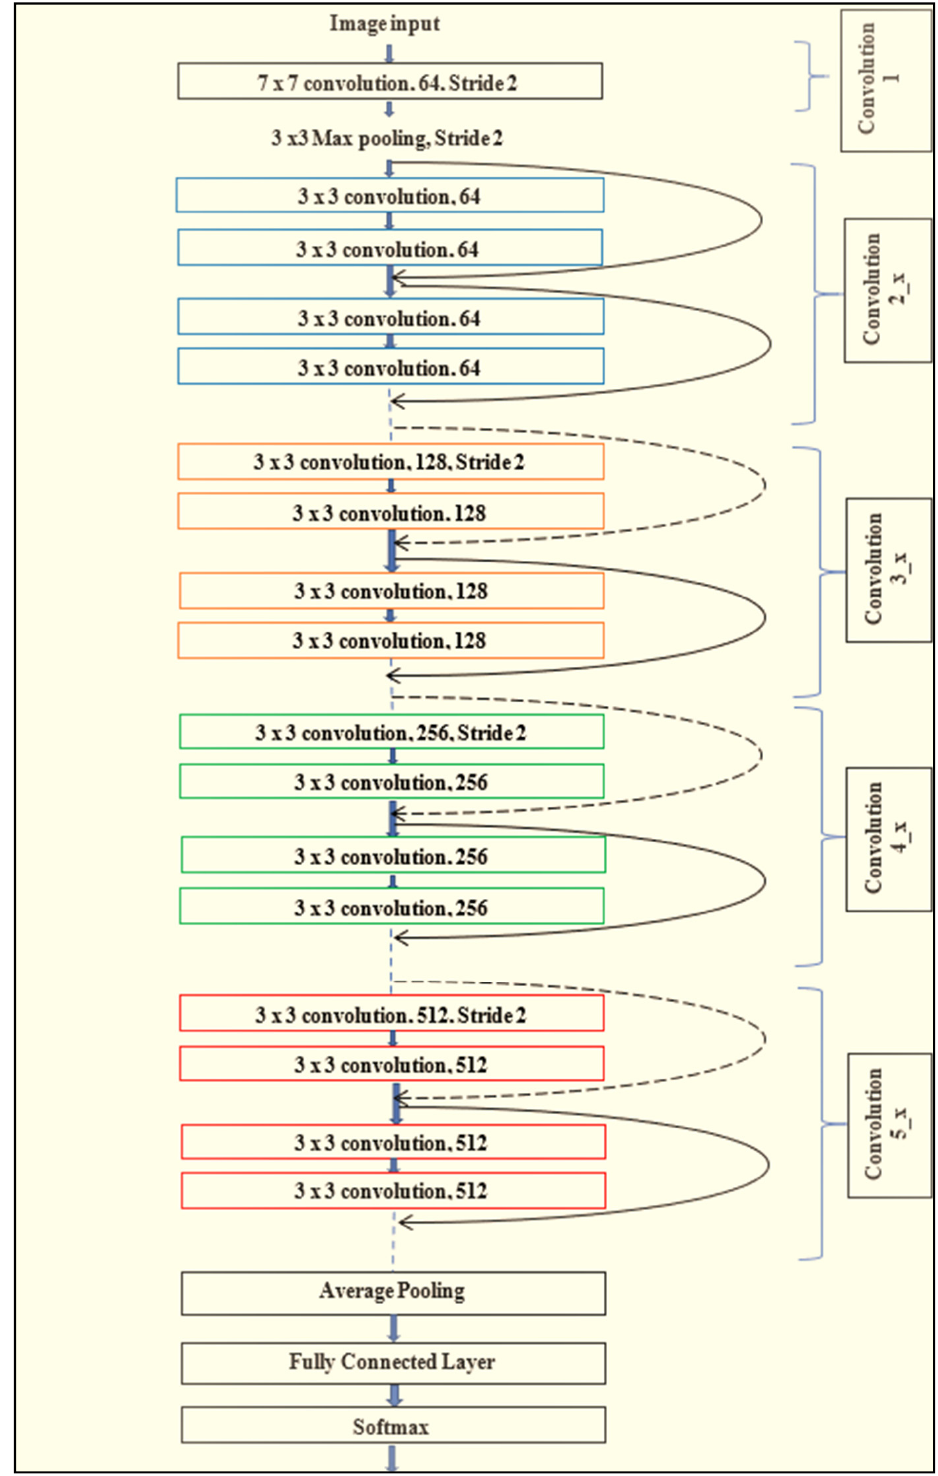
Figure 7. The architecture of ResNet; where x refers to an individual building block and the number of building blocks depends on the total number of layers present in the architecture.